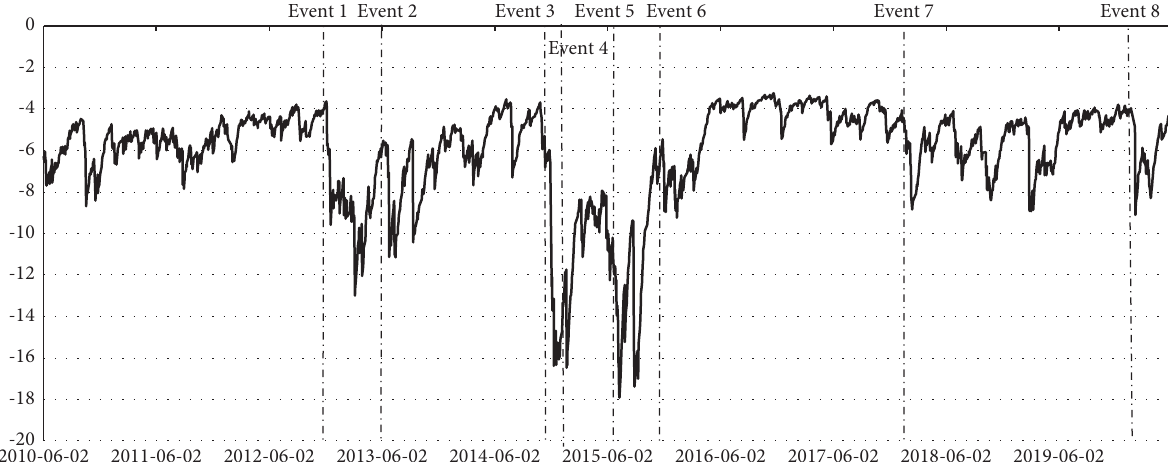
Figure 1: Risk spillover effects of SMEs on banks ( △ CoVaR, α � 5%).